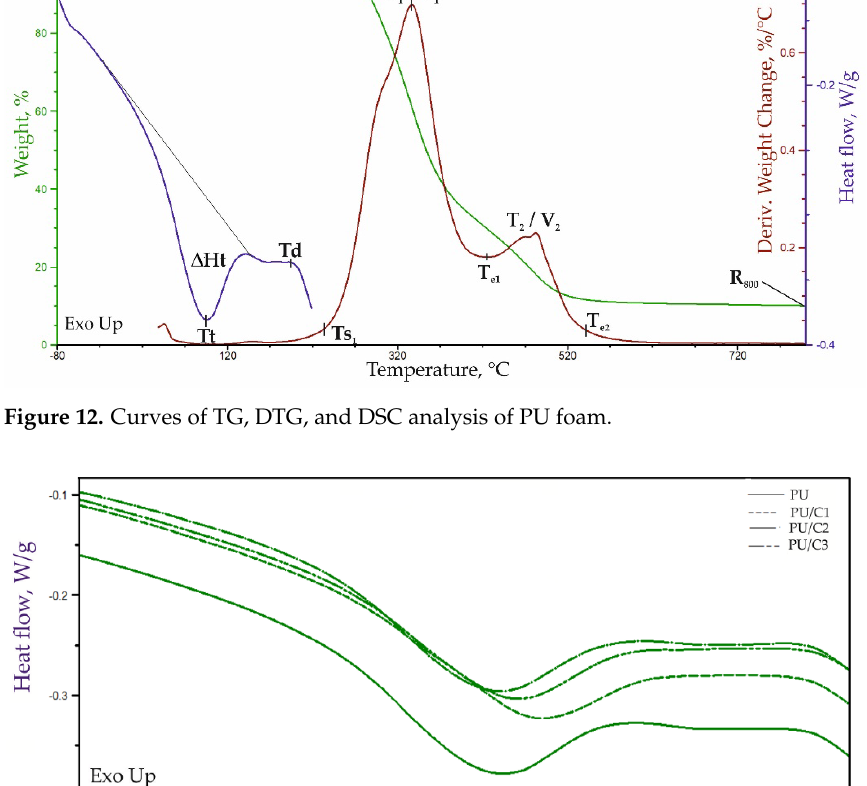
Figure 11. Changes in compressive strength and apparent density of PU foams with microcellulose.